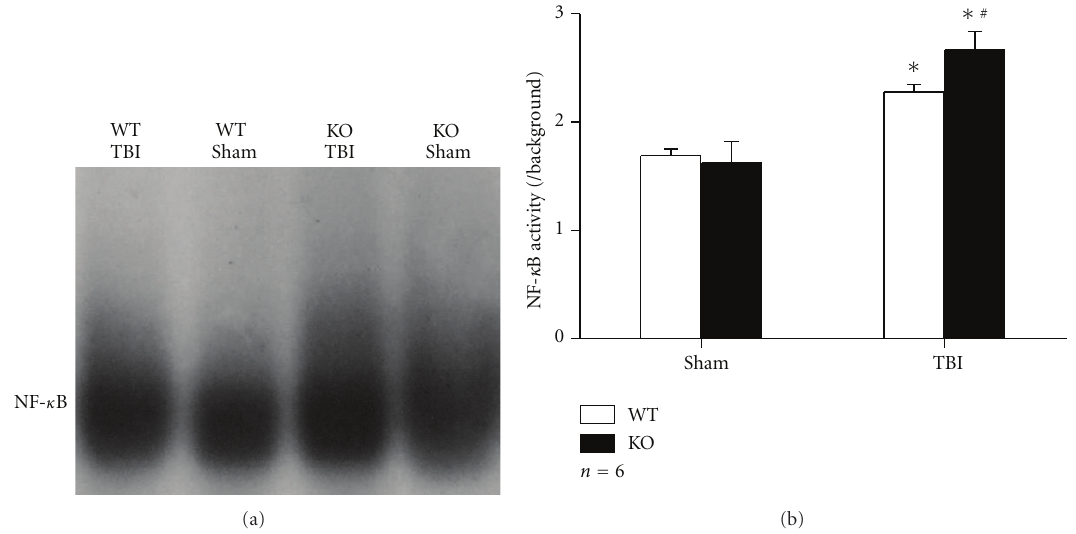
Figure 2: EMSA analysis for DNA-binding activity of NF- κ B. (a) Representative film shows DNA-binding activity of NF- κ B in Nrf2 WT or KO astrocytes 24 h after scratch or not. (b) Quantification of NF- κ B DNA-binding activity was performed by ImageJ. NF- κ B DNA-binding activity in astrocytes increased after scratch ( P < 0 . 01) and was prominently greater in group KO TBI than in group WT TBI ( P < 0 . 01). ( ∗ P < 0 . 01, compared with sham counterpart; # P < 0 . 01, compared with WT